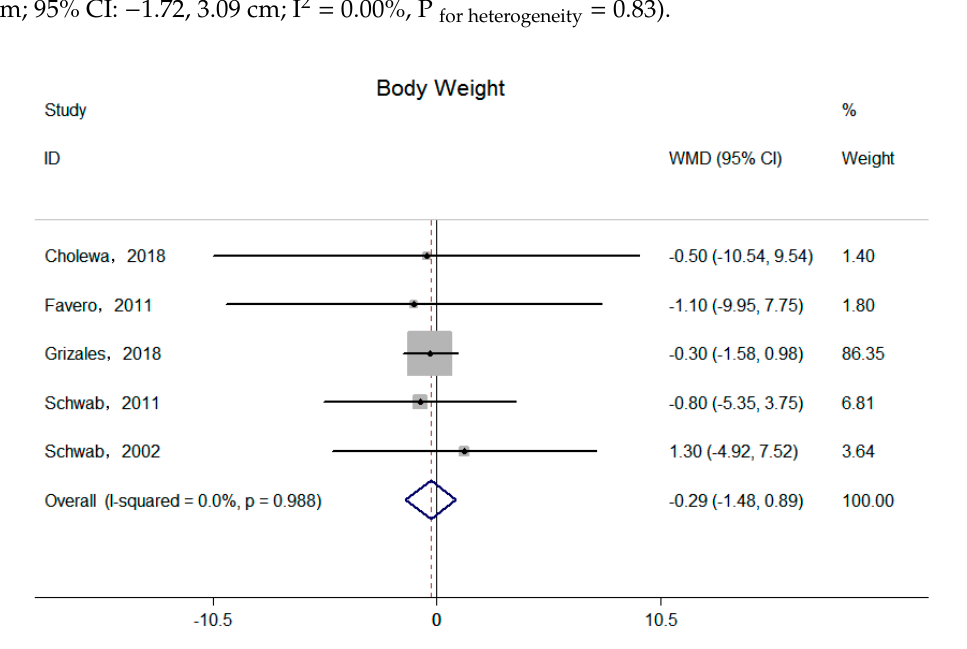
Figure 2. E ff ects of supplemental betaine on body weight in participants. The pooled e ff ect was Figure 2. Effects of supplemental betaine on body weight in participants. The pooled effect calculated by using a random-e ff ects model. The diamonds denote summary risk estimate, and was calculated by using a random-effects model. The diamonds denote summary risk horizontal lines represent 95% estimate, and horizontal lines represent 95% CI.